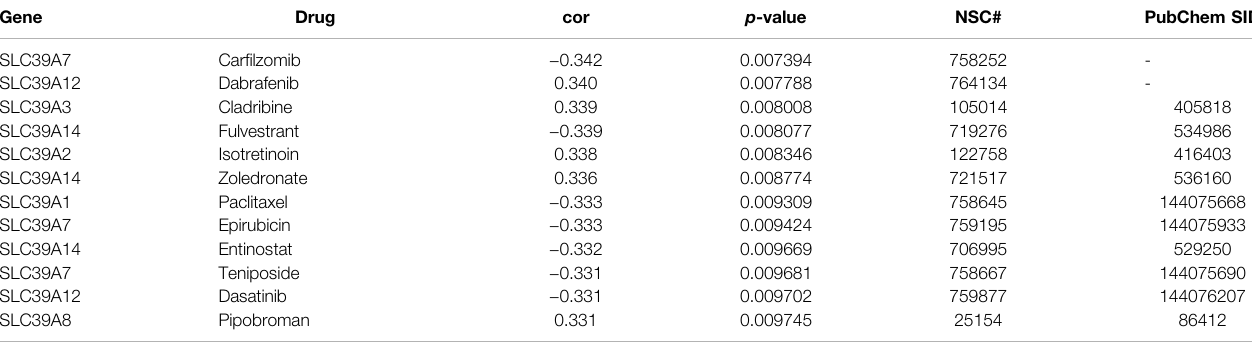
TABLE 2 | ( Continued ) Relationship between SLC39A family gene expression and drug sensitivity based on the NCI-60 cell